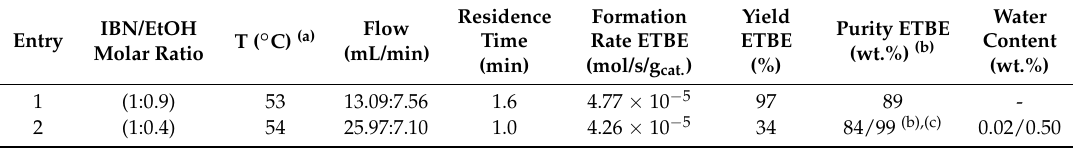
Table 4. Data set and process parameters for 100% renewable ETBE production in liter-scale (process pressure 2.4 MPa, catalyst volume 33